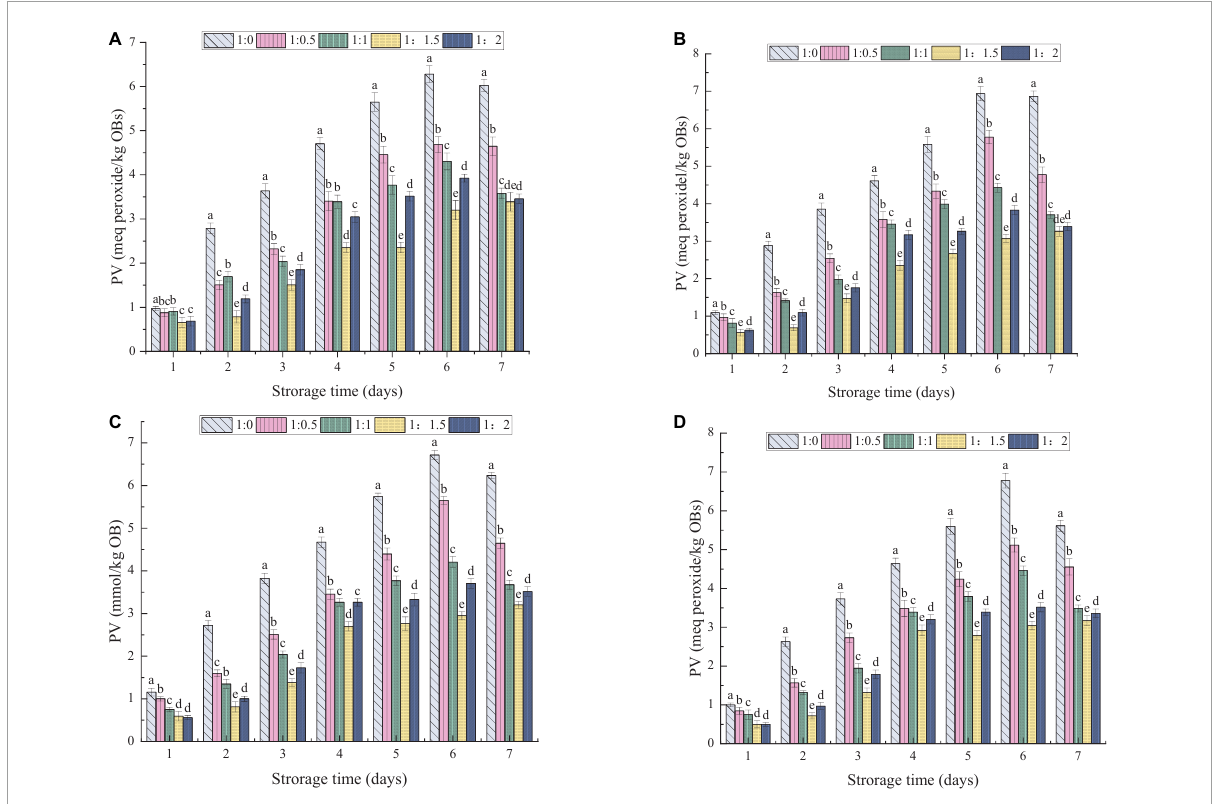
FIGURE8 Effect of different dextrin addition and ultrasonic power on PV value of OB-MD: (A) no ultrasound, (B) ultrasonic 100 W, (C) ultrasonic 175 W, and (D) ultrasound 250 W. Different letters (a–e) in the figure indicate significant differences ( P <